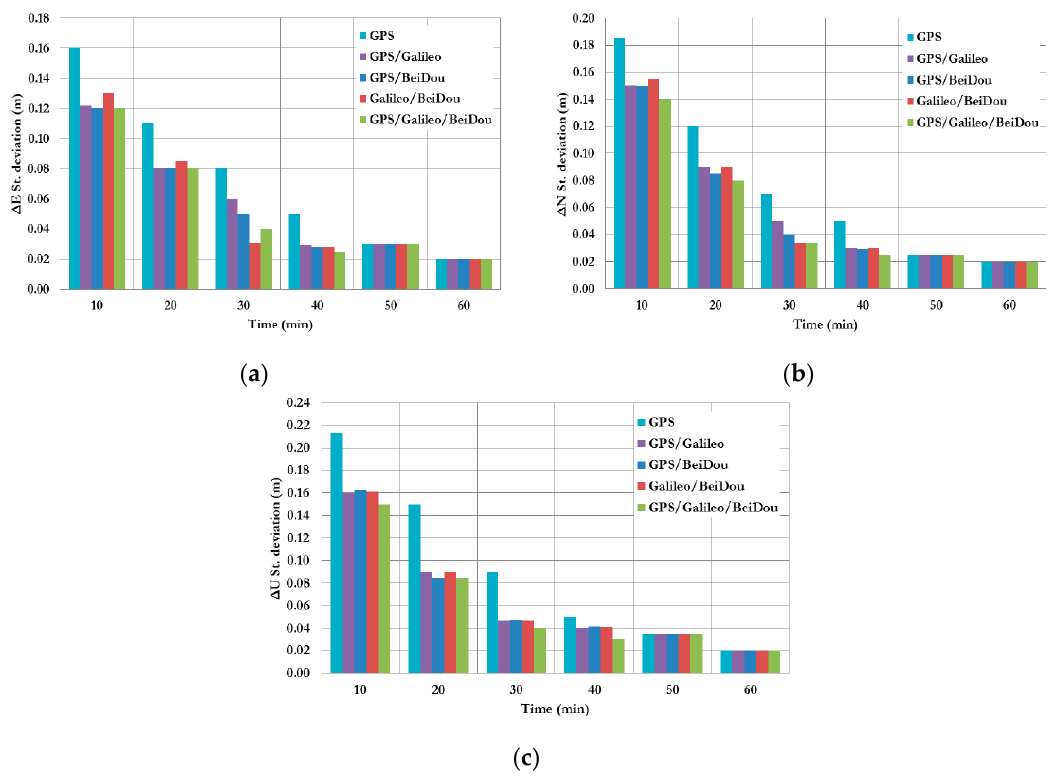
Figure 4. Summary of positioning standard deviations in East, North, and Up directions of all un-differenced post-processed PPP solutions. ( a ) East standard deviation; ( b ) North standard deviation;